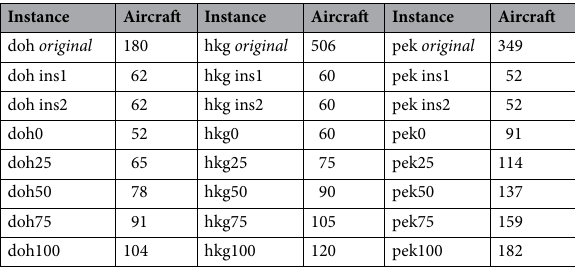
Table 3. Aircraft traffic instances.